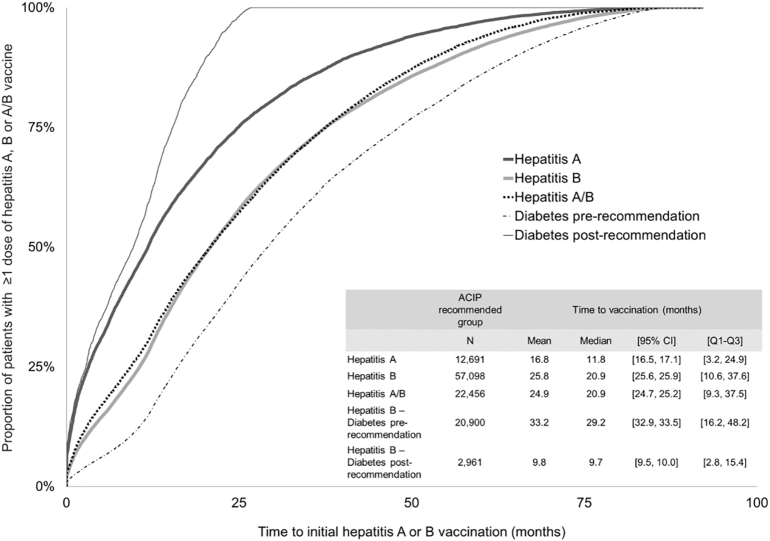
Time from first ACIP recommended condition diagnosis⁎ to initial hepatitis A, hepatitis B and hepatitis A/B vaccination, and time from diabetes diagnosis† to initial hepatitis B vaccination, 2007–2015. ⁎The diagnosis of select ACIP recommended conditions took place during the baseline period or on the index date i.e. ≥12 months before the index date. The select ACIP recommended conditions used: a) acute and chronic hepatitis B or C, chronic liver disease (CLD), clotting-factor disease, high-risk sexual behavior, or illicit drug use, for the hepatitis A cohort and b) acute and chronic hepatitis C, chronic kidney disease, CLD, diabetes, dialysis, end-stage renal disease, high-risk sexual behavior, human immunodeficiency virus, illicit drug use, sexually transmitted disease, and pregnancy, for the hepatitis B cohort. †For diabetes patients, the median time to hepatitis B vaccination was estimated and stratified by date of diabetes diagnosis (≤ or > of December 23, 2011, when the year diabetes was first included in the ACIP recommended conditions (Centers for Disease Control and Prevention, 2011)). Abbreviations: ACIP, Advisory Committee on Immunization Practices; CI, confidence intervals